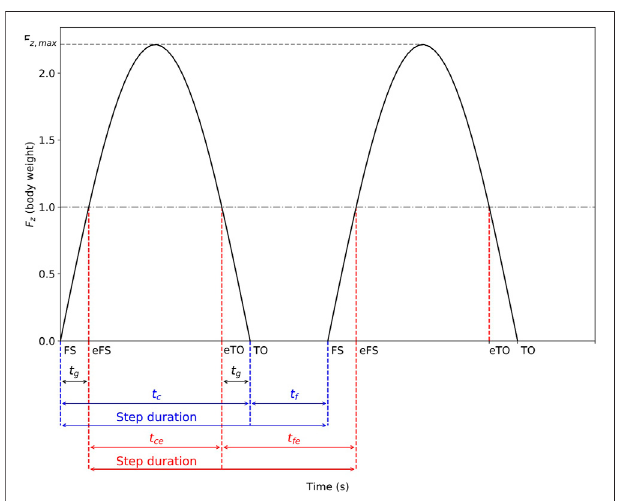
FIGURE 1 | Vertical ground reaction force ( F z ) under the sine wave approximation, peak vertical force ( F z , max ) , foot-strike (FS) and toe-off (TO) events together with their corresponding effective events (eFS and eTO), as well as contact ( t c ) , fl ight ( t f ) , effective contact ( t ce ) , and effective fl ight ( t ) times, and time to reach body weight ( t ) , for a typical running stride. fe g Noteworthy, step duration is the same when using effective or usual